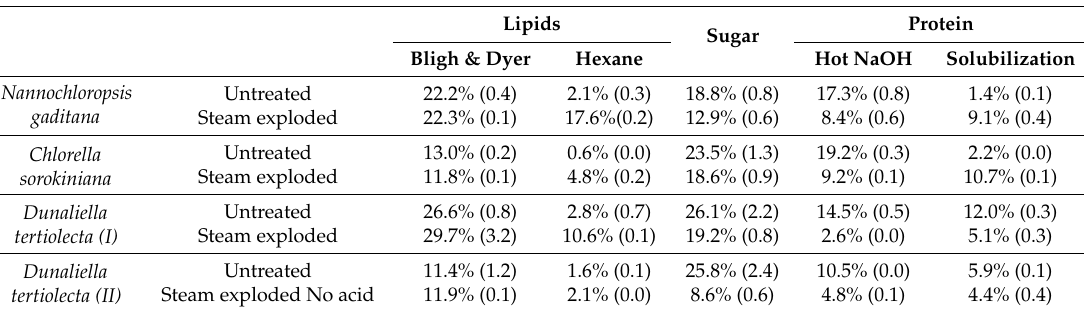
Table 1. Results of lipid, sugar, and protein analysis of steam explosion experiments (150 ◦ C, 5 min and 5% w / w . H 2 SO 4 except sample D. tertiolecta (II) with no acid). Values are expressed as the mean and the standard deviation is indicated in